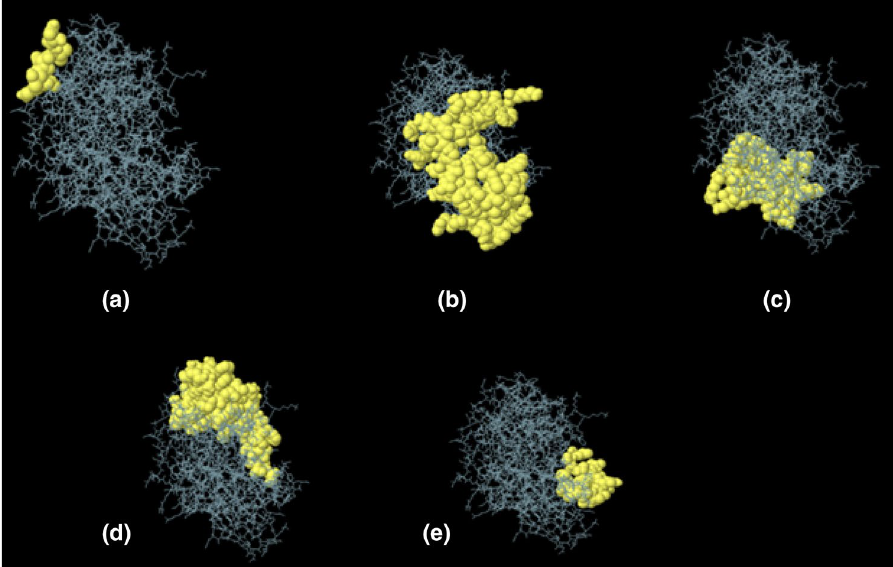
Figure 9. Discontinuous B-cell epitopes predicted by ElliPro. ( A – E ): 3D representation of conformational or discontinuous epitopes of the most antigenic chimeric protein from T. cruzi CL Brenner. Epitopes are shown as yellow surfaces, and the bulk of the protein is represented in grey sticks (JSmol 13.3.9—https:// sourc eforge. net/ proje cts/ jsmol/).